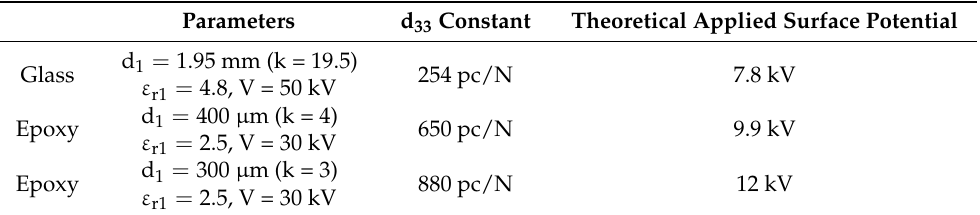
Table 1. Maximum d 33 constant obtained and estimated theoretical applied surface potential of the sample with the three different